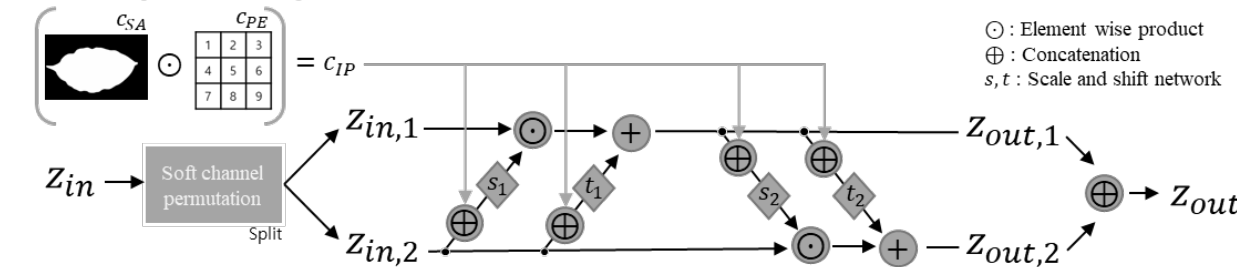
Figure 2. Conditional affine coupling block with proposed instance-aware positional